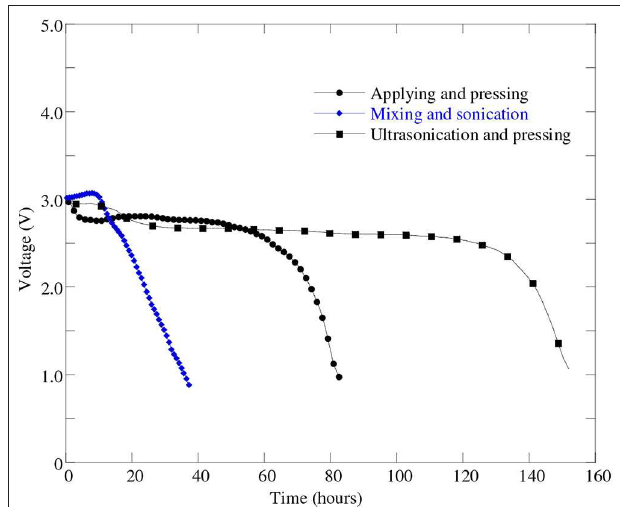
FIGURE 6 | Discharge profiles of battery cells at 0.1mA (i.e., 50 mA/g) discharge current with different cathode processes: “applying and pressing” (cell#51B), “mixing and sonication” (cell#64A), and “ultra-sonication and pressing” (cell#78C).